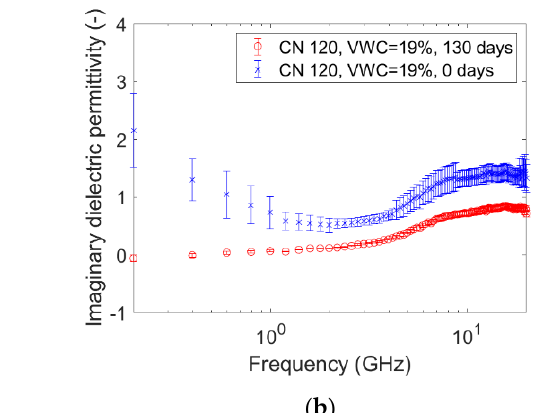
Figure 6. Complex dielectric permittivity before bioremediation and after 130 days: real part ( a ), imaginary part ( b ). Microcosm: C/N = 120. Volumetric water content = 19%.